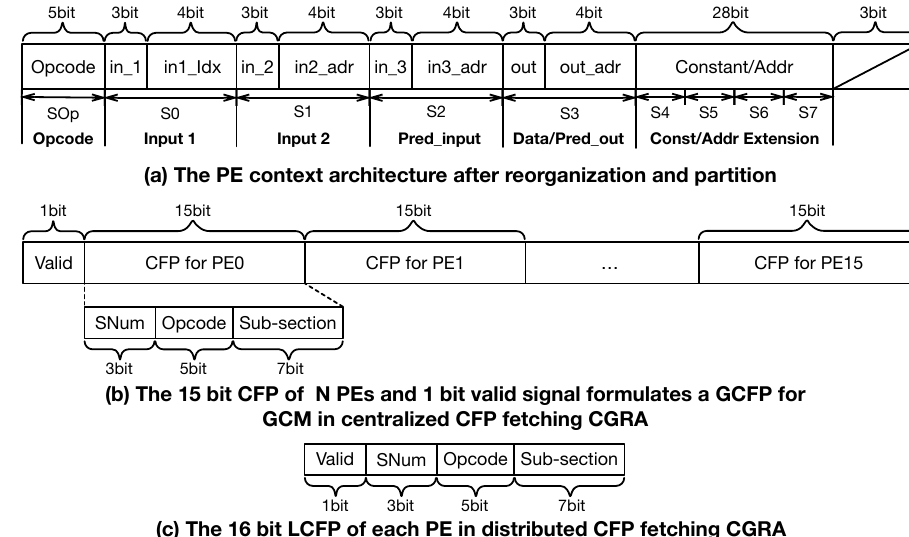
Figure 7. The reorganized context format of HReA [18] and two different CFP formats for two CGRA architectures proposed in this